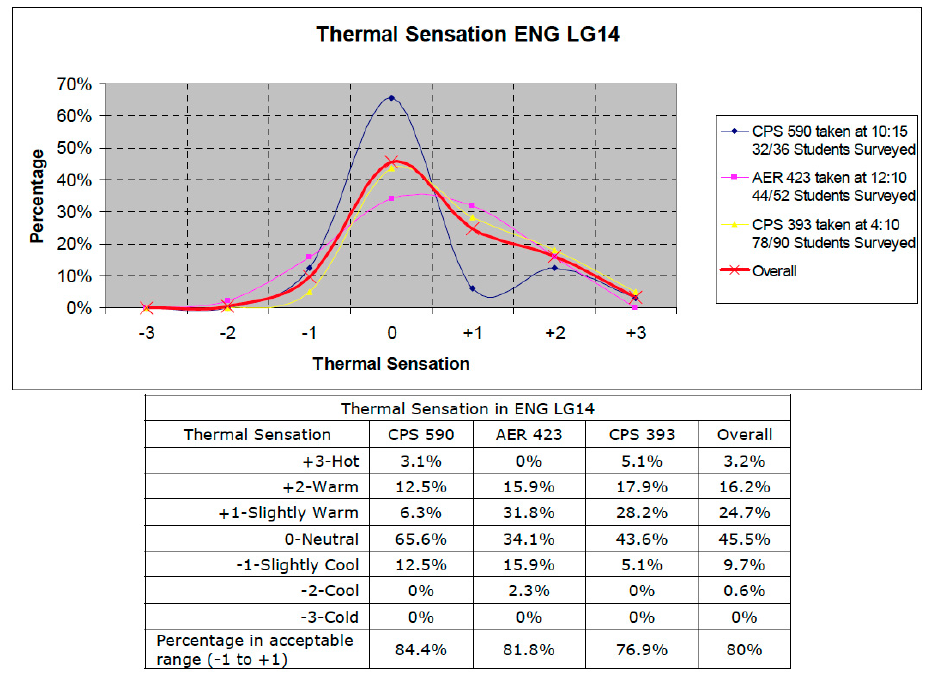
Figure A2. Thermal Sensation Survey Results. Note that CPS 590, AER 423, and CPS 393 are lecture course codes respectively.